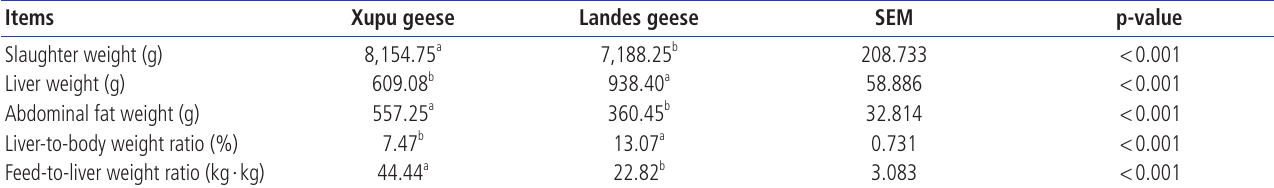
Table 3. Comparison of slaughter traits between overfed Xupu and Landes geese Items Xupu